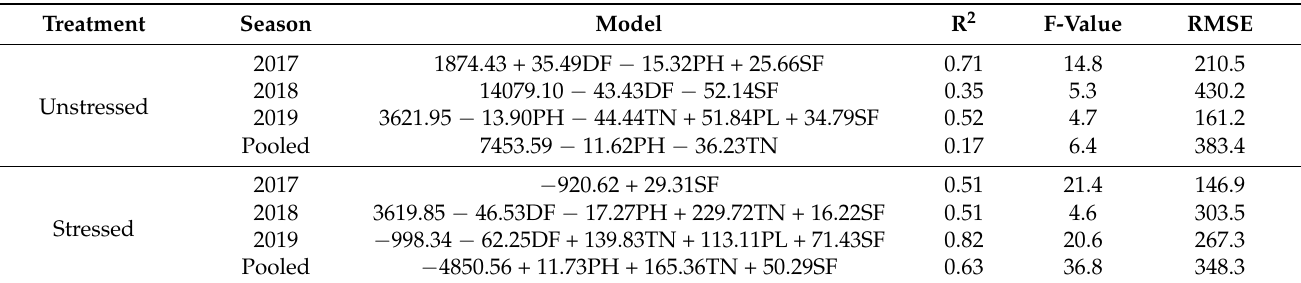
Table 6. Stability model for PB1 NILs along with checks under stressed and unstressed treatments during Kharif seasons of 2017, 2018 and 2019.